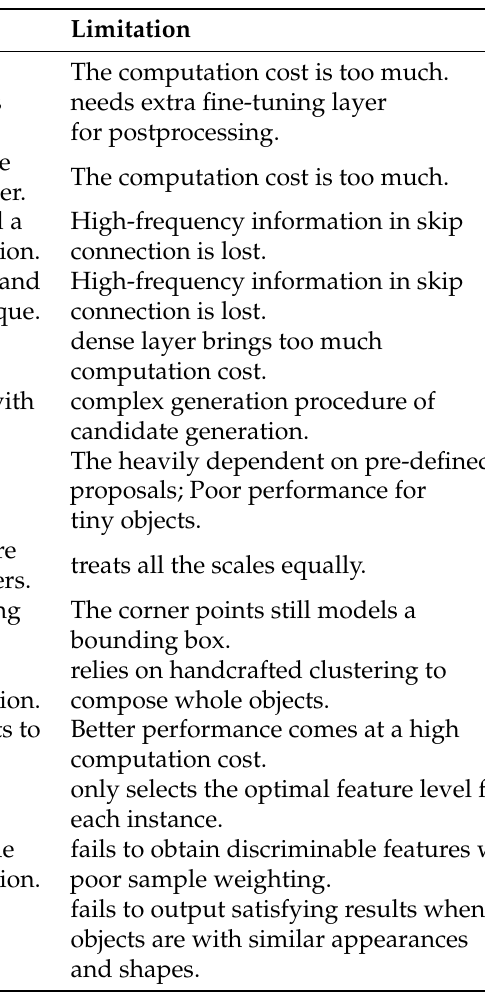
Table 1. A summary of the related